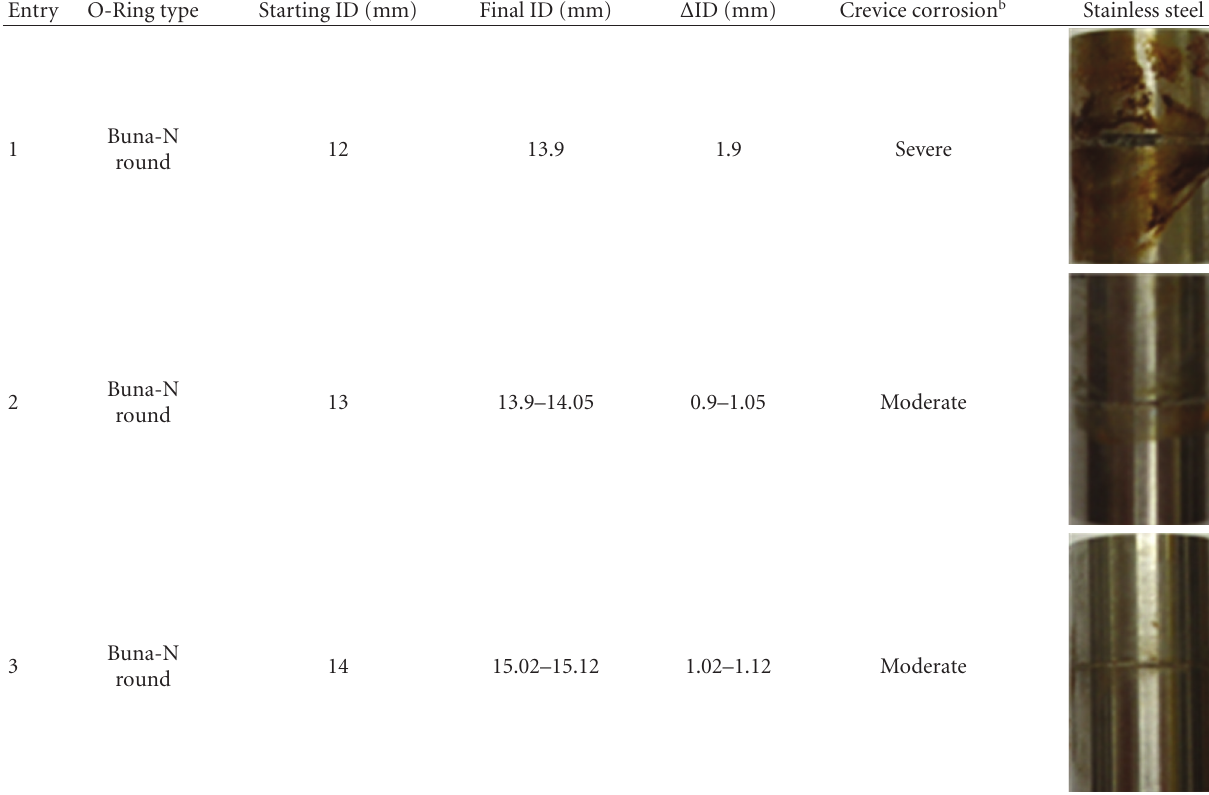
Table 1: Deformation of Buna-N round O-rings fitted on 316 stainless steel.